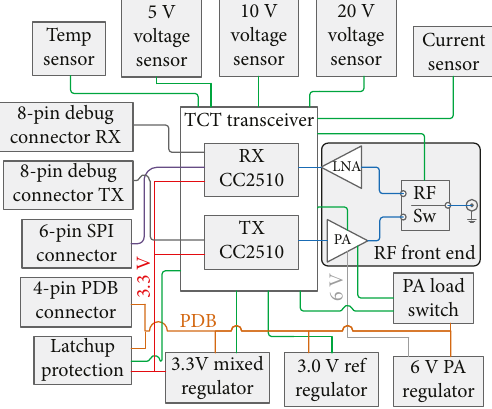
Figure 9: Block view of the S-band 1B9_CubeTCT